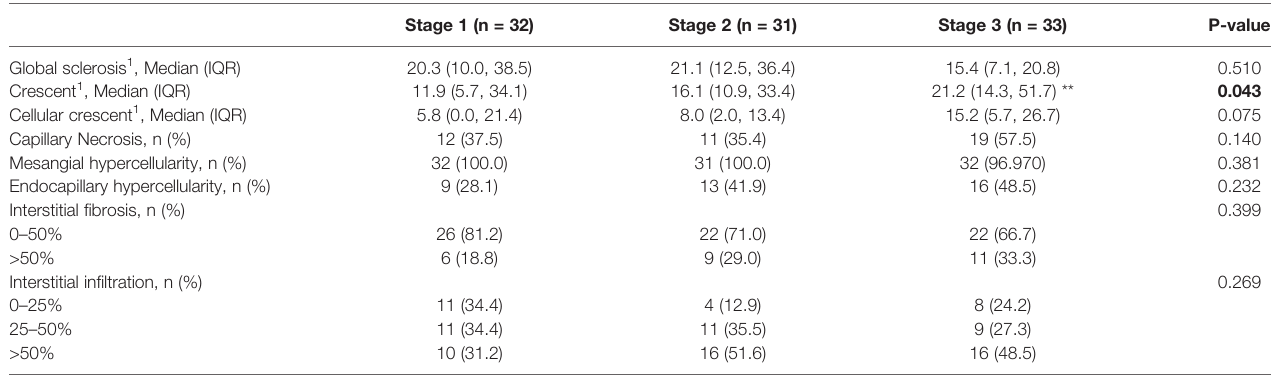
TABLE 2 | Pathological characteristics of AAV patients in different AKI